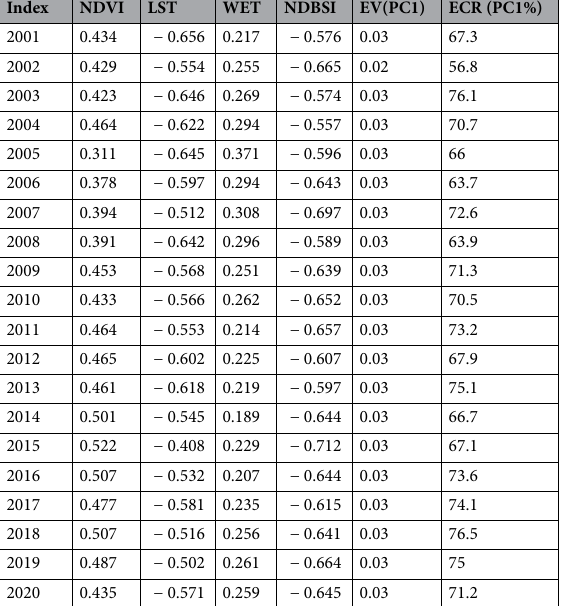
Table 3. Analysis results of RSEI principal component from 2001 to 2020.